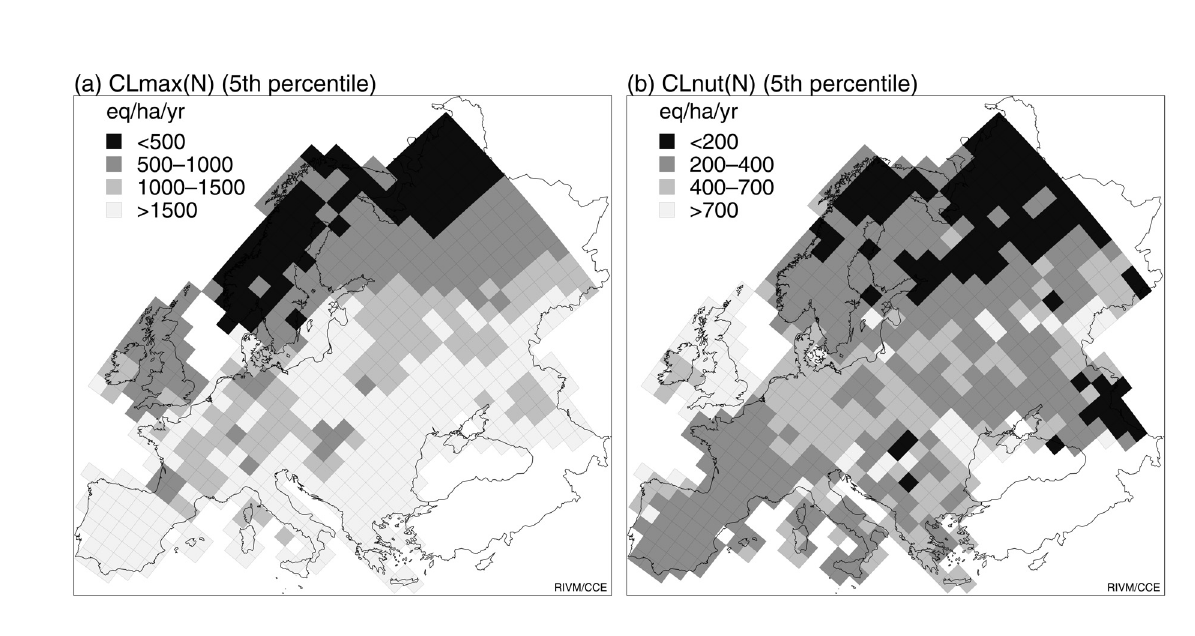
FIGURE 2. Fifth percentile of the maximum critical load of nitrogen (left) and the critical load of nutrient N (right) in the EMEP 150 × 150 km 2 deposition grid covering Europe (1000 eq/ha = 1.4 gN/m 2